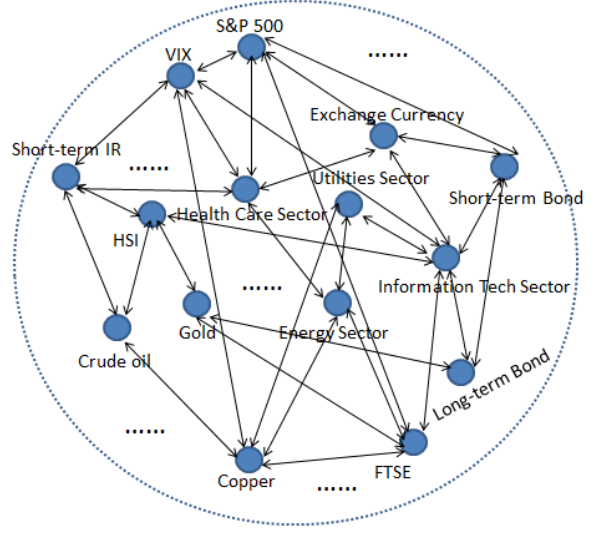
Figure 1. The Structure of Financial